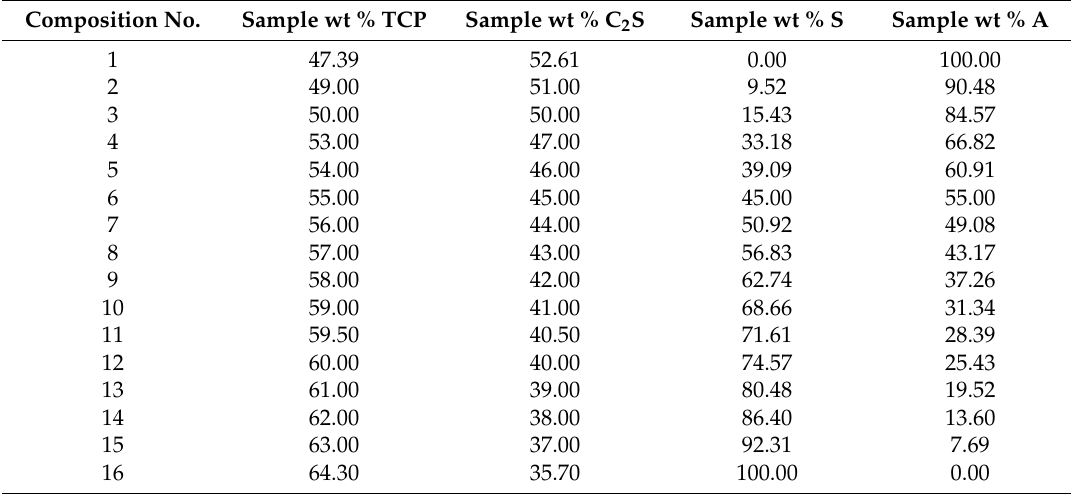
Table 4. Composition of the